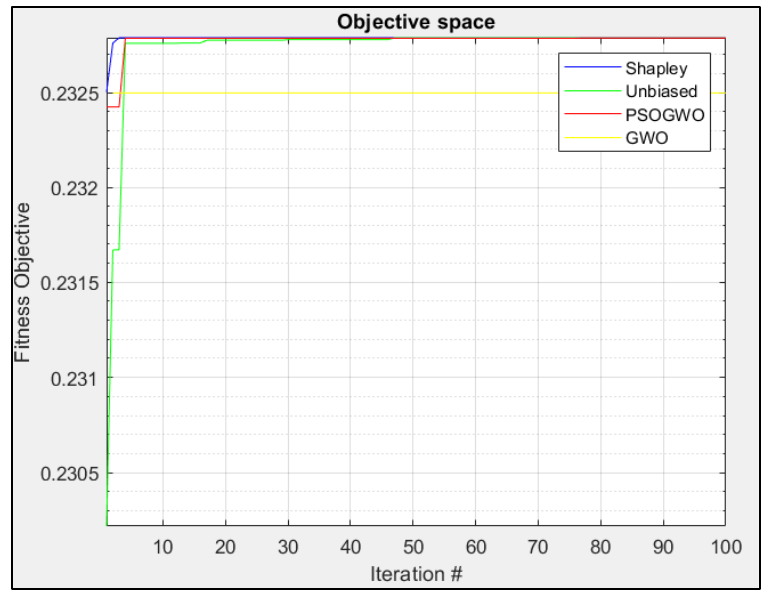
Figure 5. Convergence characteristics.